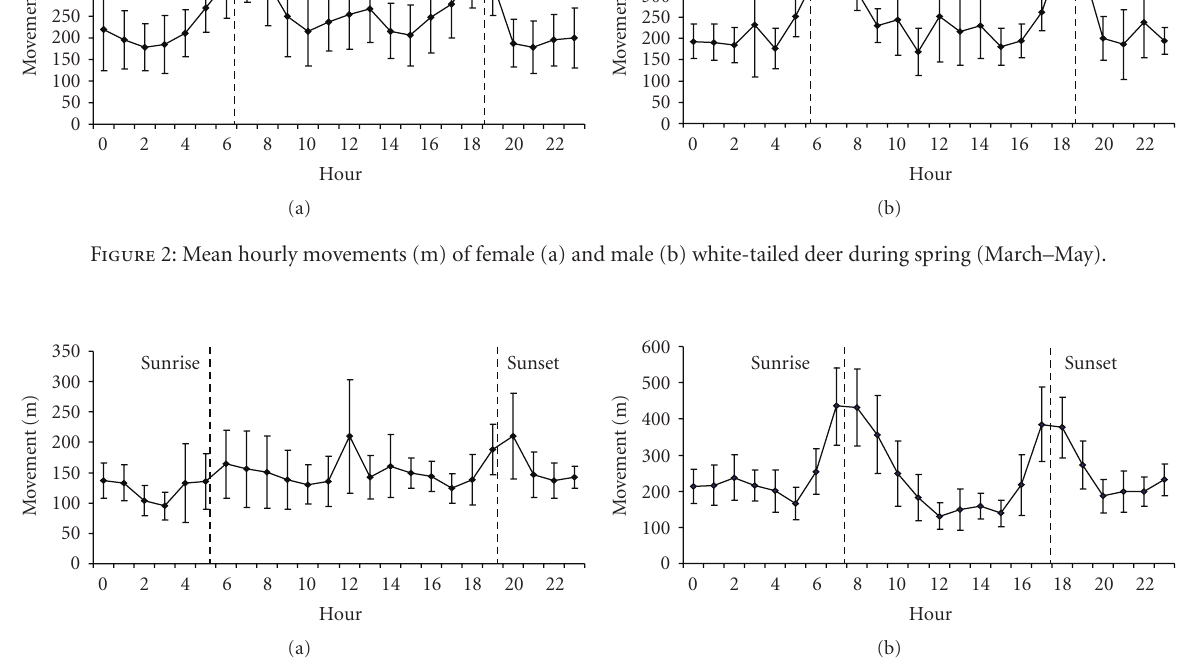
Figure 3: Mean hourly movements (m) of female (a) white-tailed deer during summer (June–August) and male (b) white-tailed deer during winter